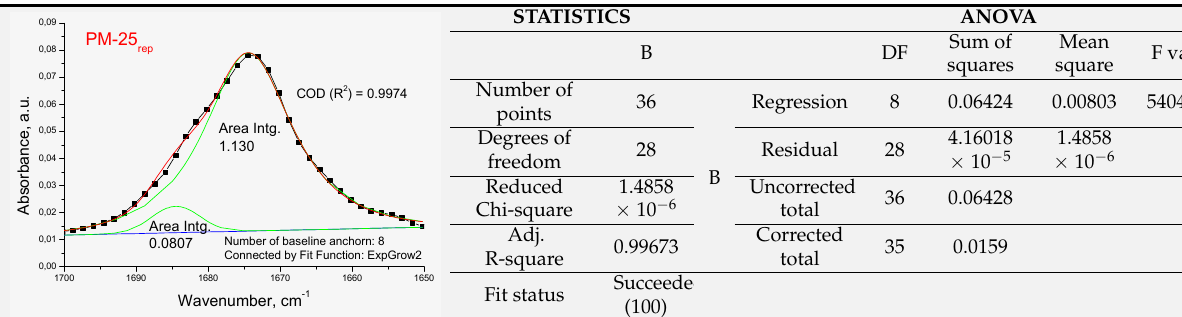
Table A10. Sample P-25 rep.